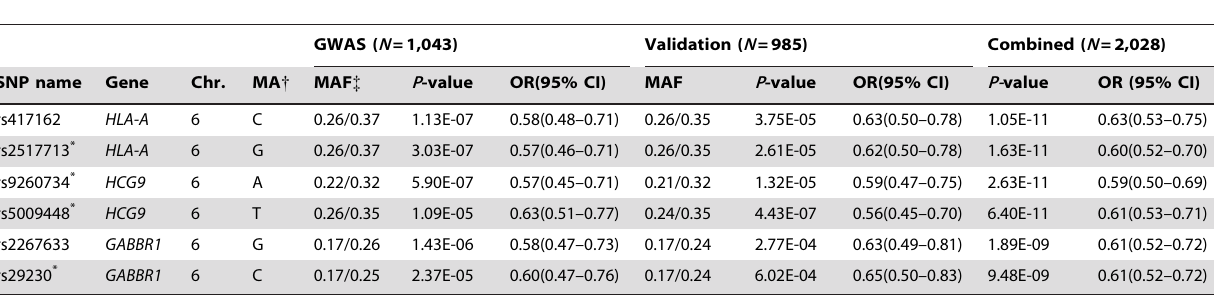
Table 1. GWAS and validation of SNPs association data in two independent NPC cohorts.